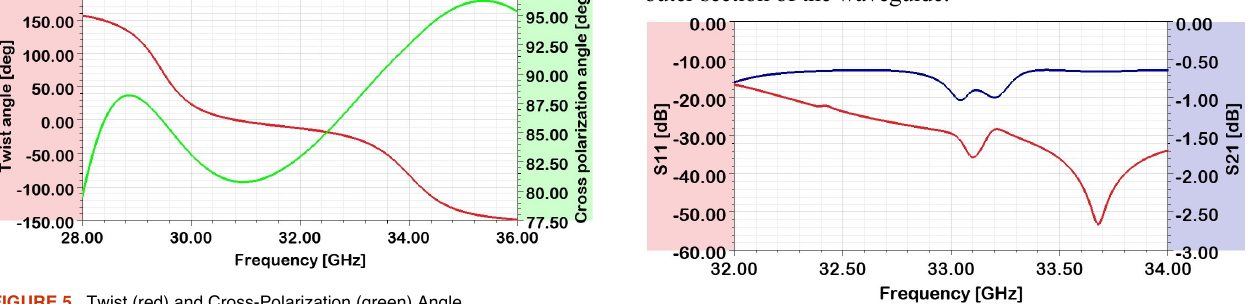
FIGURE 5. Twist (red) and Cross-Polarization (green) Angle